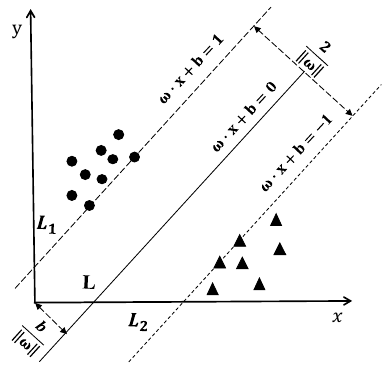
Figure 3. The optimal classification hyperplane(The circles and triangles represent the divided sample data, respectively).